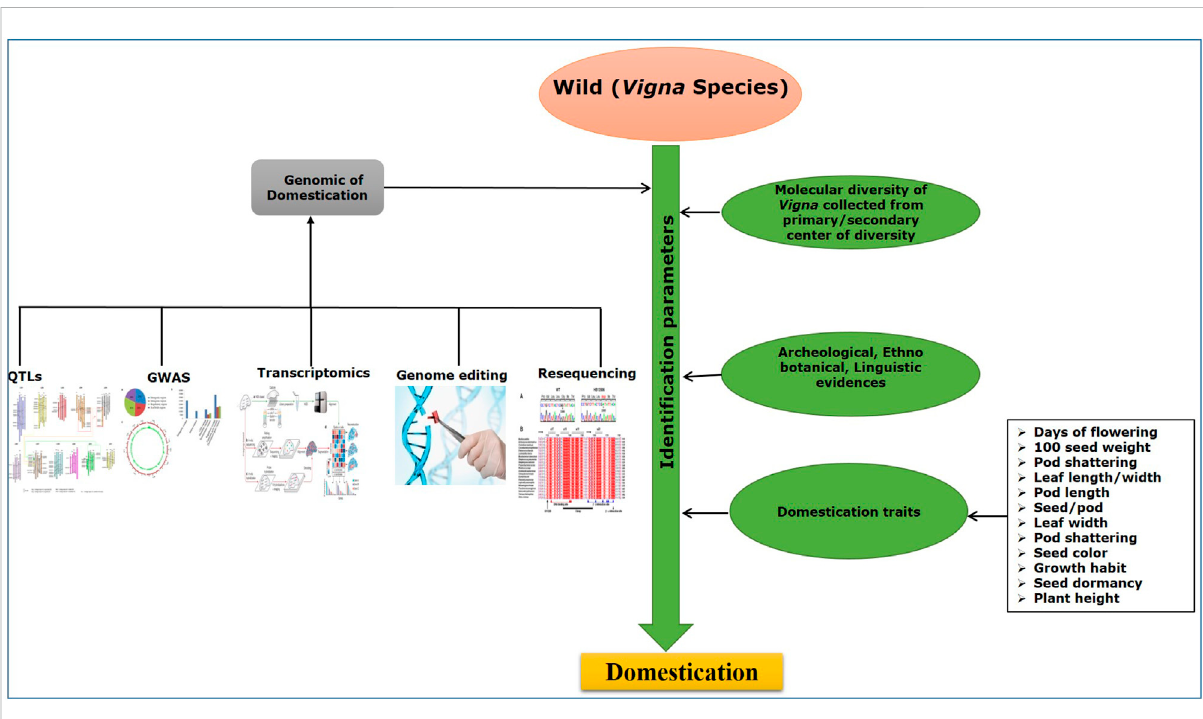
FIGURE 5 Schematic representation of various domestication-related identi fi cation parameters in Vigna species viz., primary/secondary center of diversity; ethnobotanical and linguistic approaches; domestication-related traits (DRTs); and genomic analysis that can differentiate wilds from their domesticated